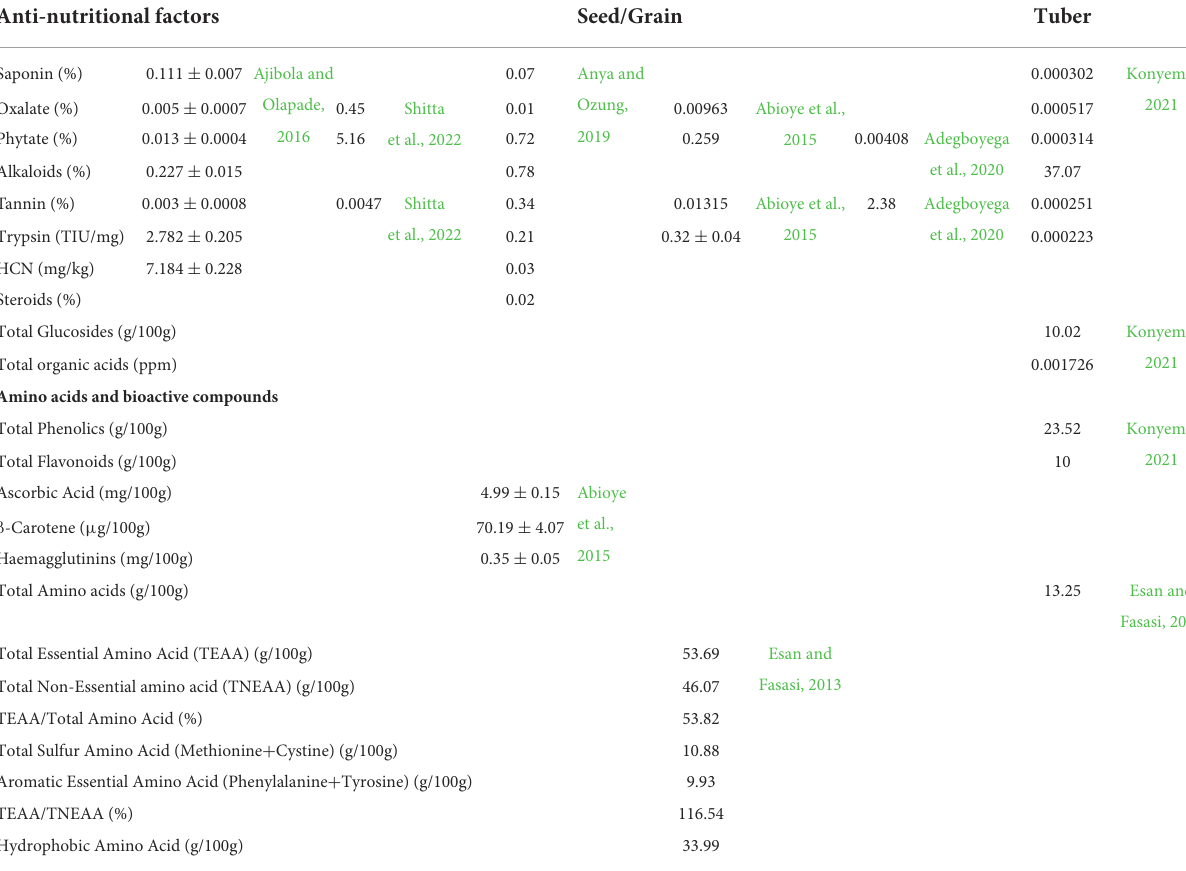
TABLE 3 Anti-nutritional factors, amino acid and bioactive compound in the seeds and tubers of African yam bean as revealed in literature. Anti-nutritional factors